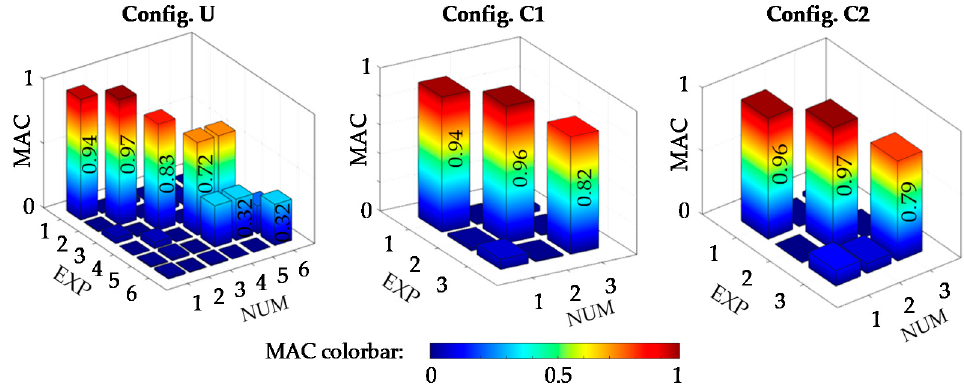
Figure 18. MAC index matrices for the comparison between the experimental and numerical mode shapes.